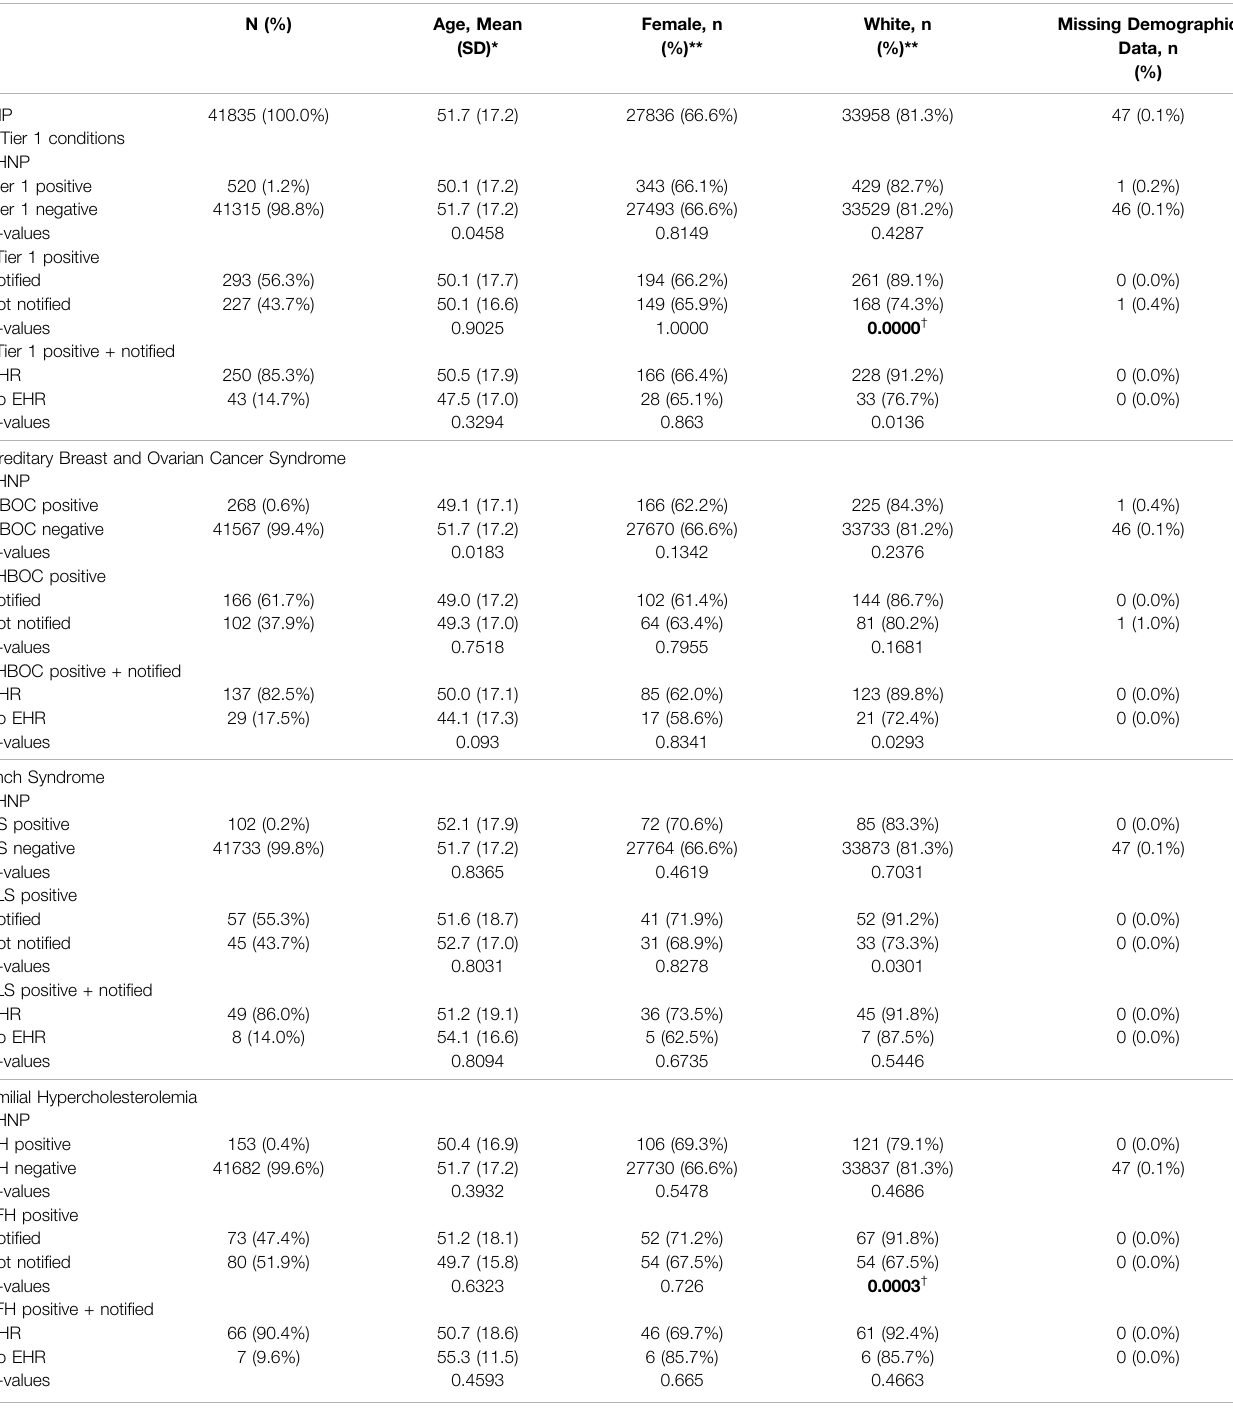
TABLE 1 | Demographic statistics associated with Tier 1 status, noti fi cation status, and whether a participant had an EHR record. Comparisons of age, sex, and ethnicity were made for all Tier 1 conditions combined, and for HBOC, LS, and FH participants